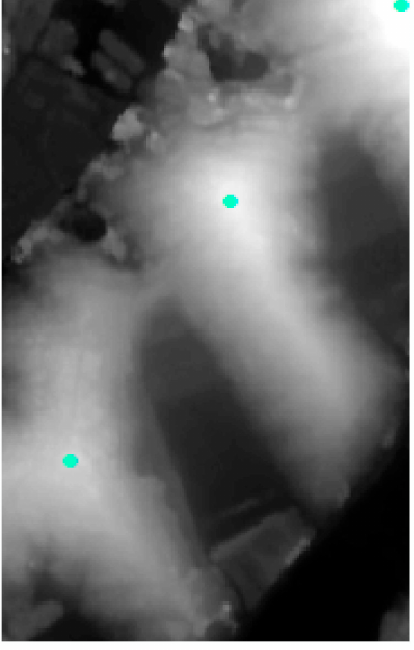
Figure 21. The distribution map of the fourth dataset extracted using the reference method.